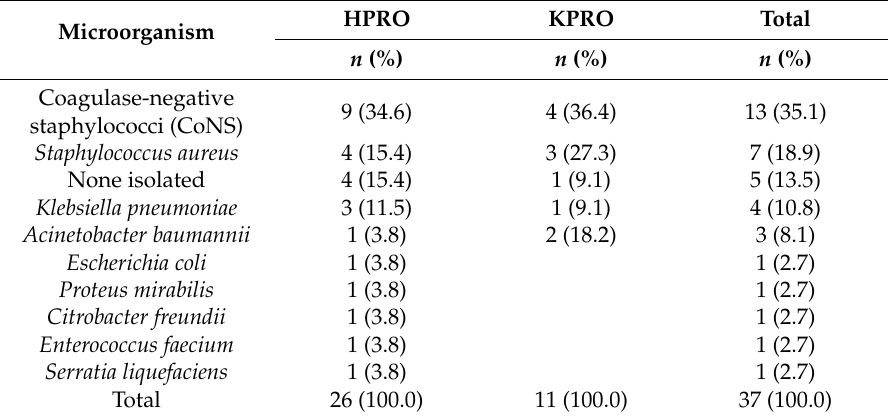
Table 5. Microorganisms isolated from patients with SSI in